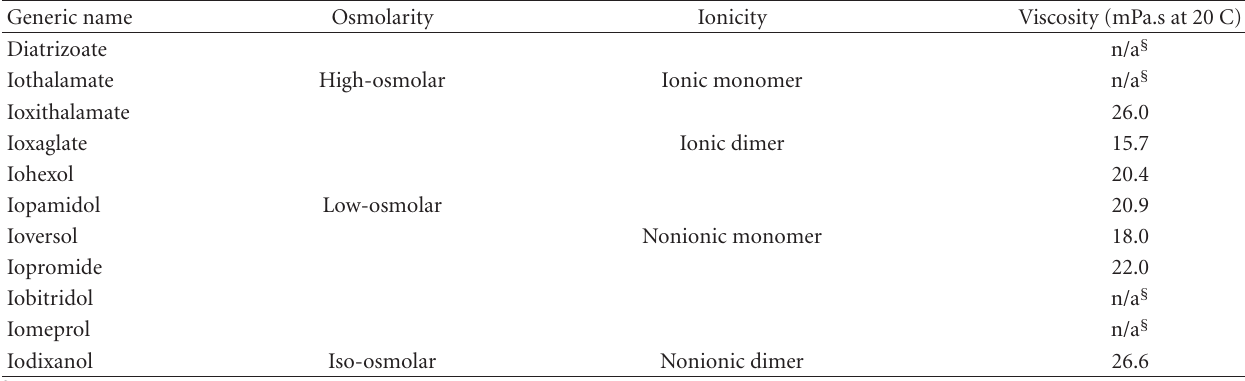
Table 2: Properties of contrast media.